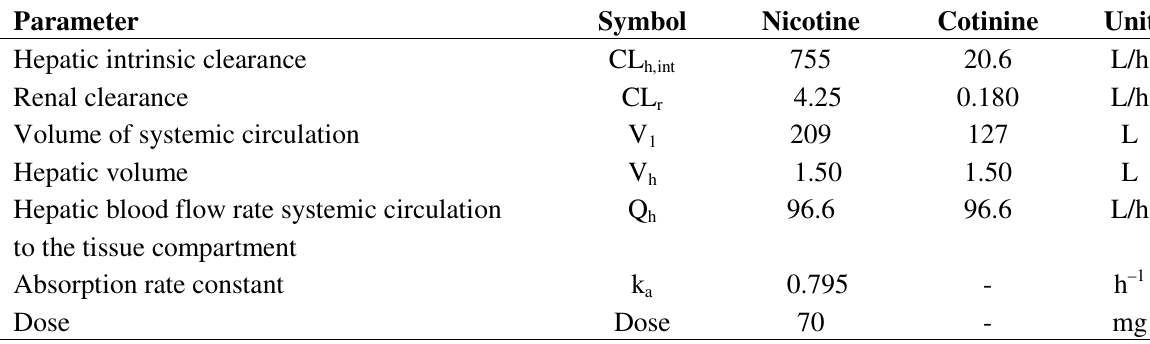
Table 2. Parameters used for the human PBPK